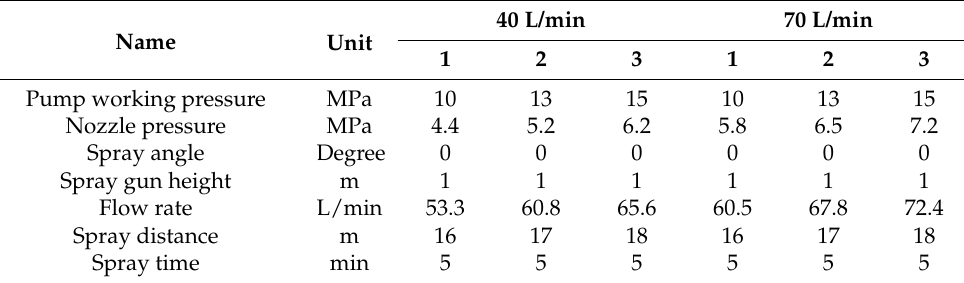
Table 3. Experiment results of the high-pressure water fire extinguishing equipment.